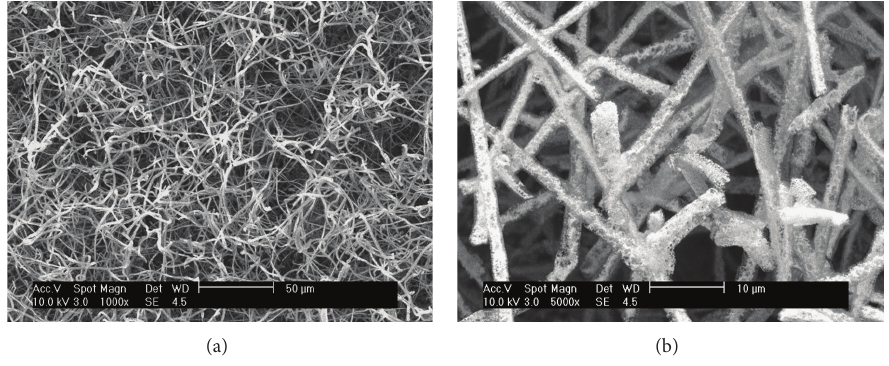
Figure 1: Low-magnification (a) and high-magnification (b) SEM images of the as-synthesized